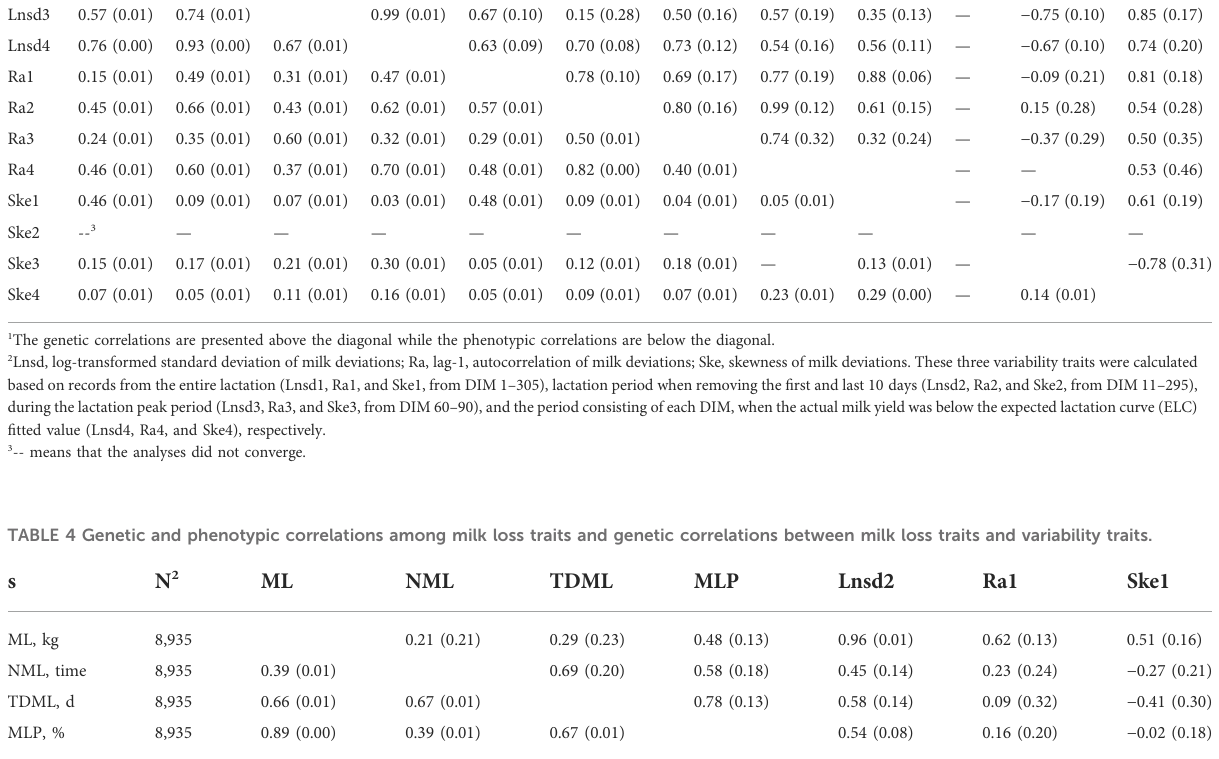
1 The genetic correlations among milk loss traits are presented above the diagonal while the phenotypic correlations are below the diagonal in the fi rst four columns, while the genetic correlations between milk loss traits and variability traits are presented in the last three columns; ML, sum of the milk yield which dropped in all fl uctuation phases in a lactation; NML, number of milk loss events; TDML, total number of days for milk loss per lactation; MLP, the percentage of ML to MY305; Lnsd2, log-transformed standard deviation of milk deviations basedonthelactationwhenremoving fi rstandlast10DIM;Ra1,lag-1autocorrelationofmilkdeviationsbasedontheentirelactation;Ske1,skewnessofmilkdeviationsbasedontheentire lactation. Lnsd1, Ra2 and Ske2 are the traits with the highest heritability among the three variability traits, respectively. 2 N: number of records that were used to calculate the genetic